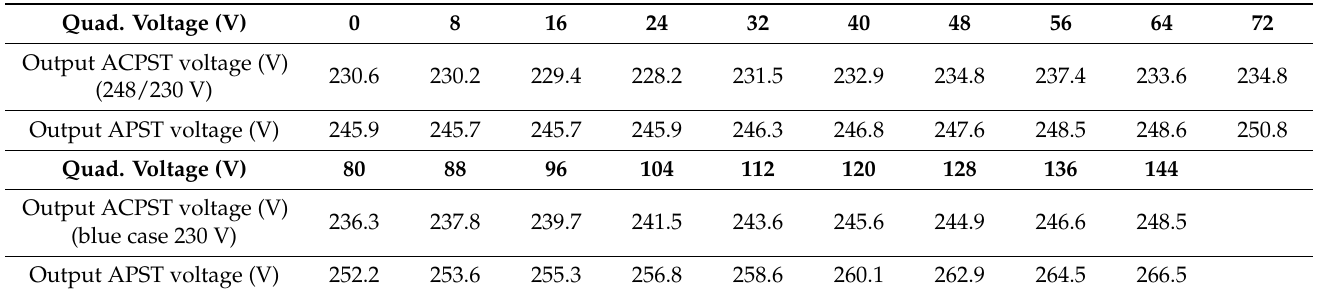
Table 5. The output voltages for APST and ACPST